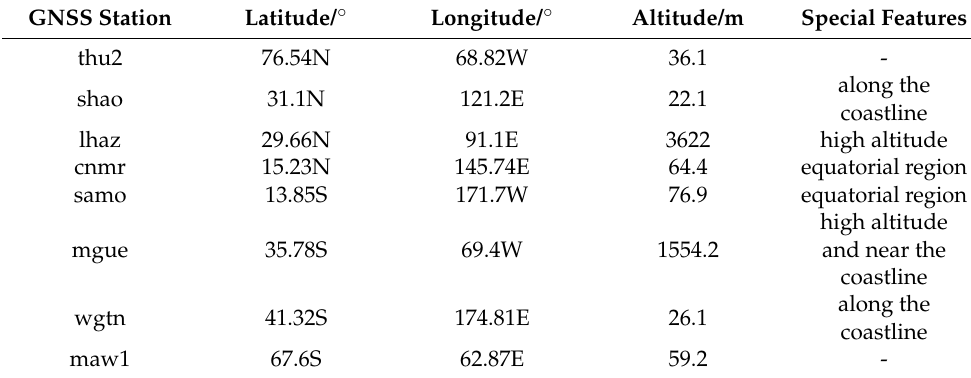
Table 3. Details of 8 GNSS